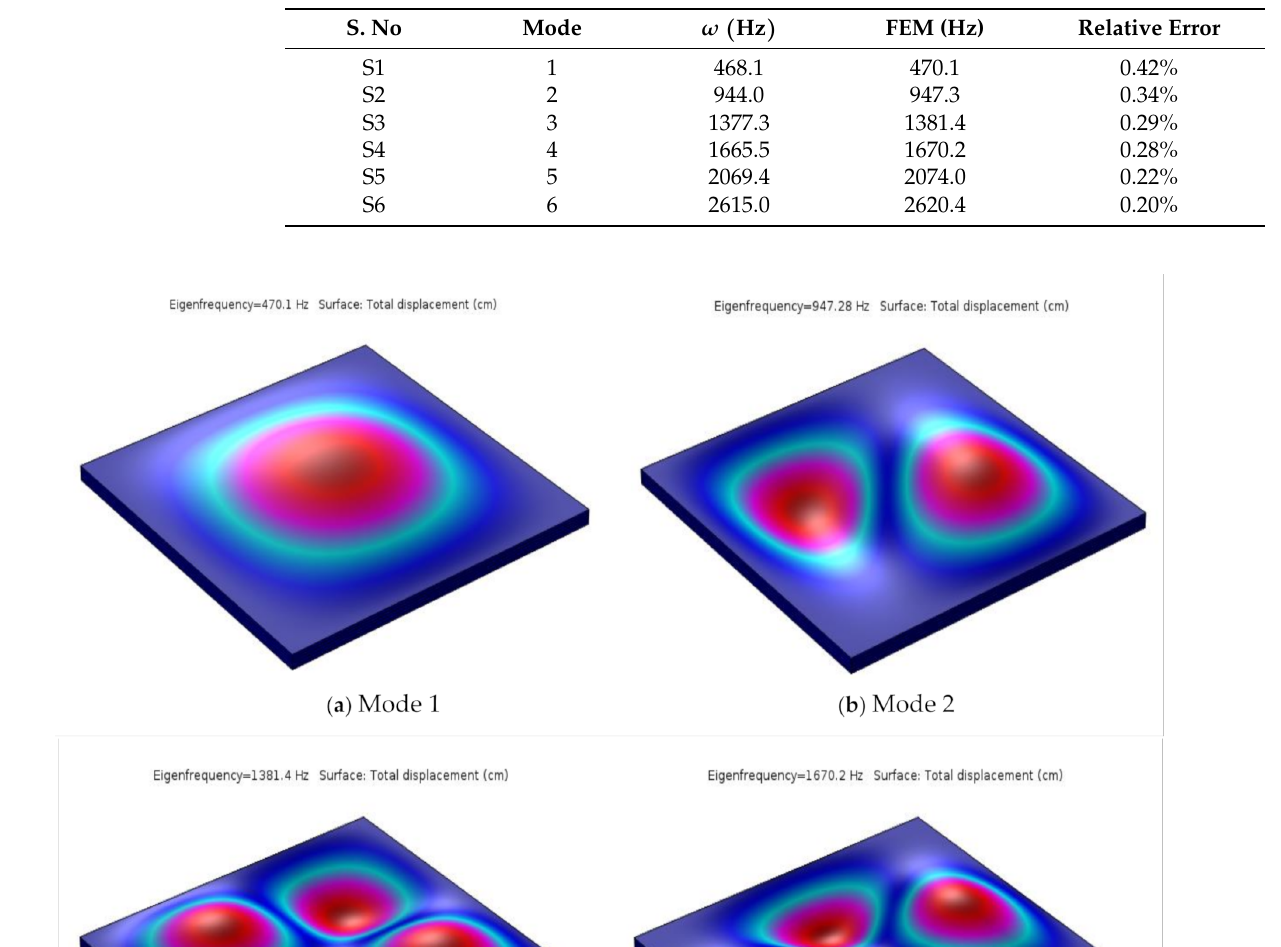
Table 7. Comparison between FEM-based predictions and results from our formulation (GPL-O).